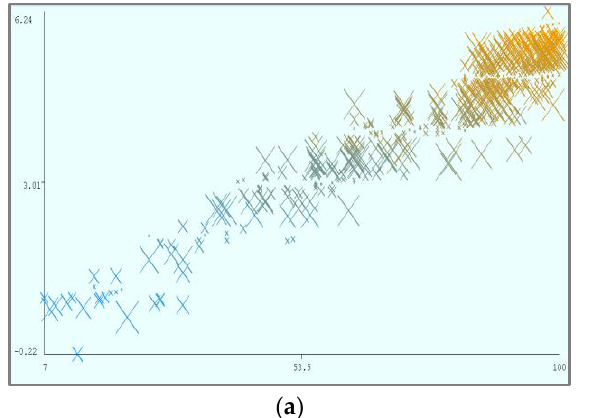
Figure 9. Combined matrix plot.